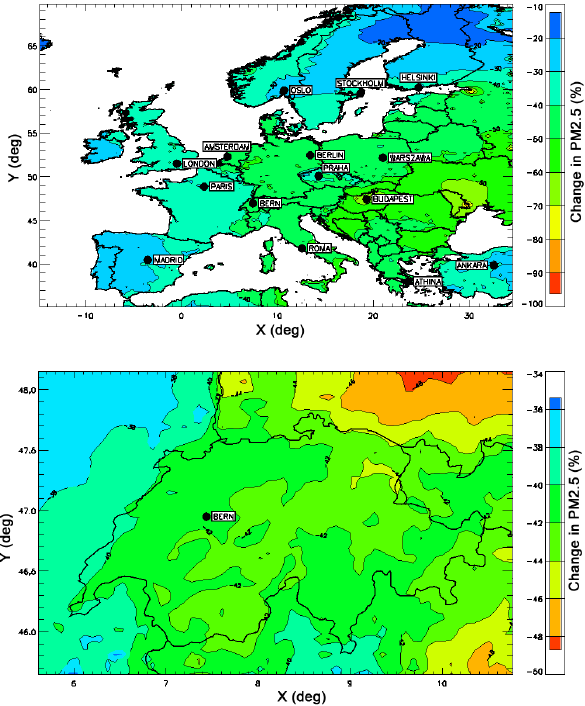
Figure 5. Relative changes in annual average PM 2 . 5 concentrations over the European (upper panel) and Swiss (lower panel) domains,